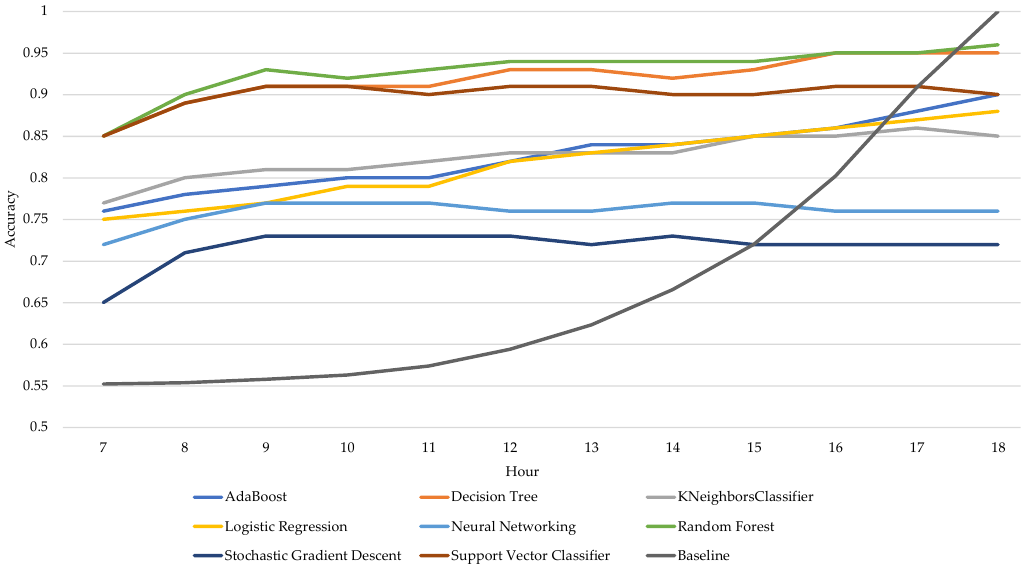
Figure 5. Average accuracy per algorithm, per hour based on the individual scores.